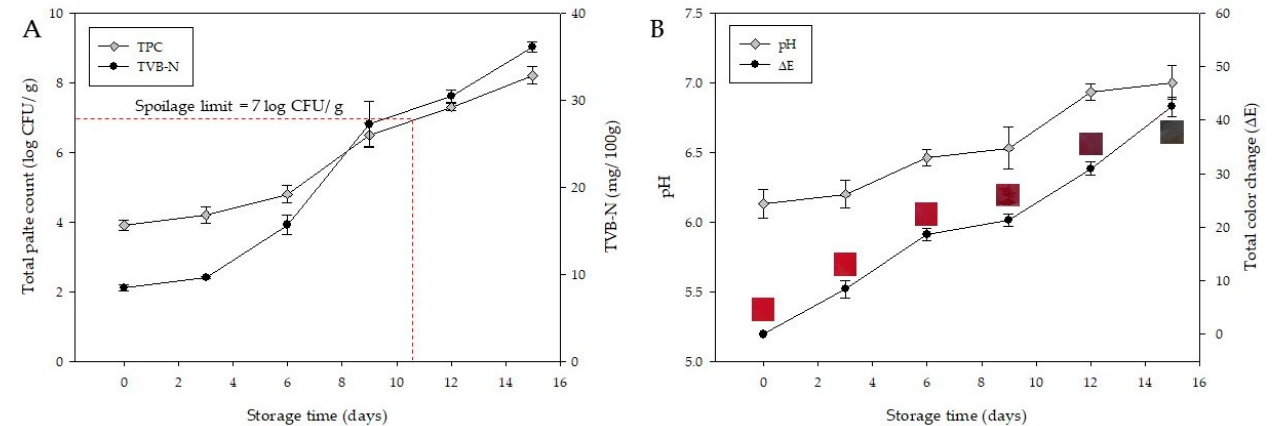
Figure 7. The changes of TPC and TVB-N of chicken tenderloin ( A ) and the change of pH of chicken tenderloin and the total color change ( Δ E) of the RA-H20MB indicator ( B ) during stored at 4 °C.